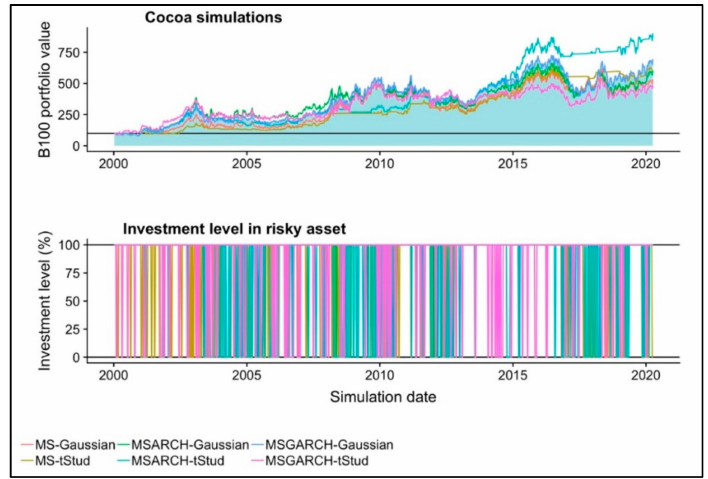
Figure 3. The historical performance and commodity investment level in each of the six simulated portfolios in the one-month cocoa future